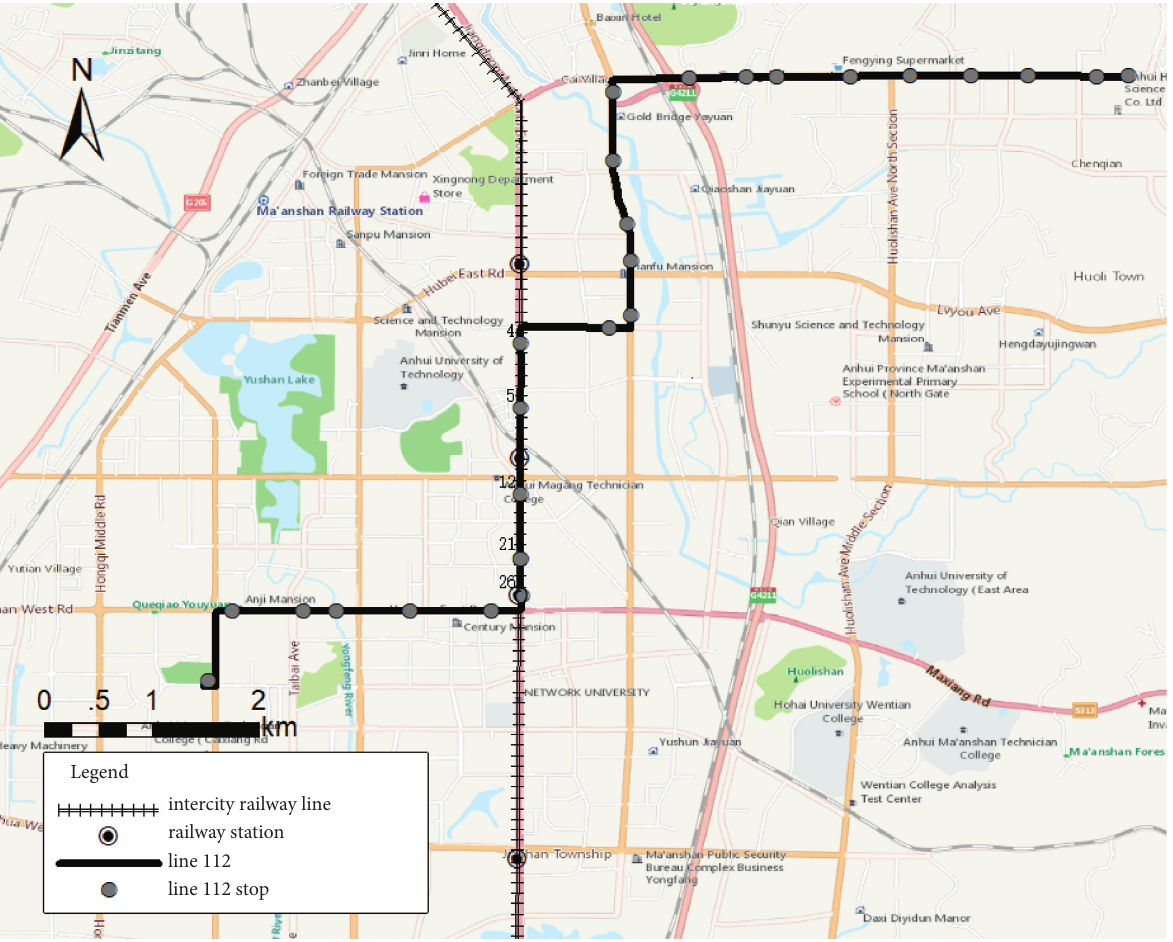
Figure 8: Alternative plans and stops of line